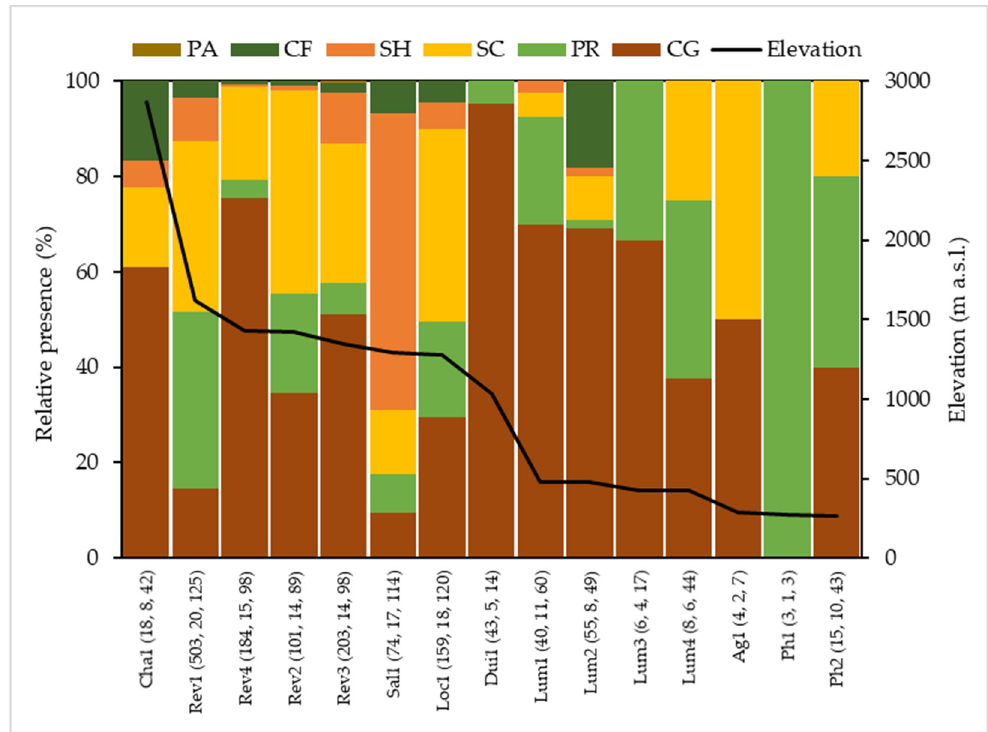
Figure 5. Functional feeding group composition per studied sites. Numbers in parenthesis indicate the total number of encountered individuals, number of taxa, and BMWP-Col score, respectively. Locations are ordered based on a decreasing elevation. CF, SH, SC, PA, PR, and CG refers to the collector-filterers, shredders, scrapers, parasites, predators, and collector-gatherers, respectively.